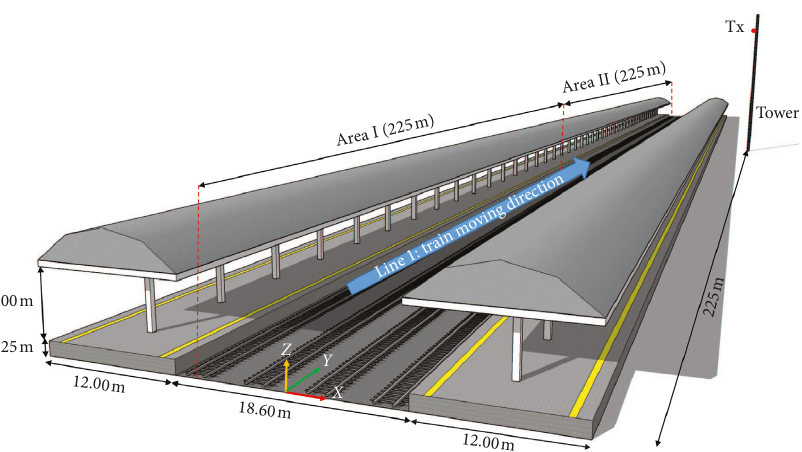
Figure 1: High-speed railway station scenario. Line 1 is divided into two parts: Area I (the area of Rx approaching the Tx) and Area II (the area of Rx leaving the Tx).